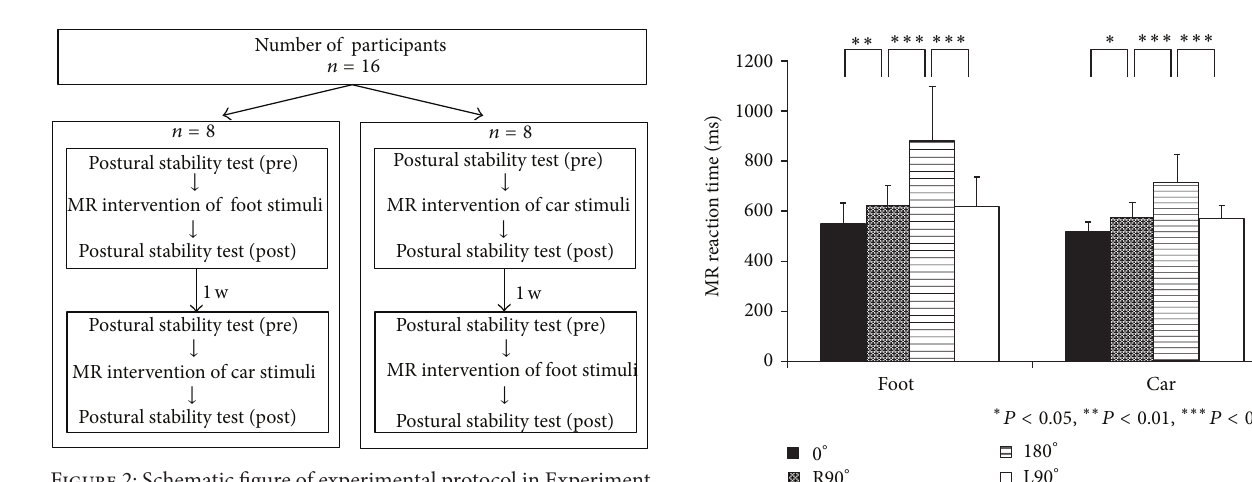
Figure 2: Schematic figure of experimental protocol in Experiment 1. All participants were involved in two intervention sessions. The order of the stimuli for mental rotation (i.e., the foot or car) presented on the first intervention day was counterbalanced on the second.